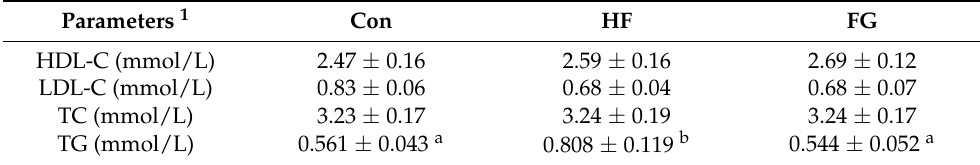
Table 3. Effect of high-fat diet and GABA supplementation on the serum lipid profile in